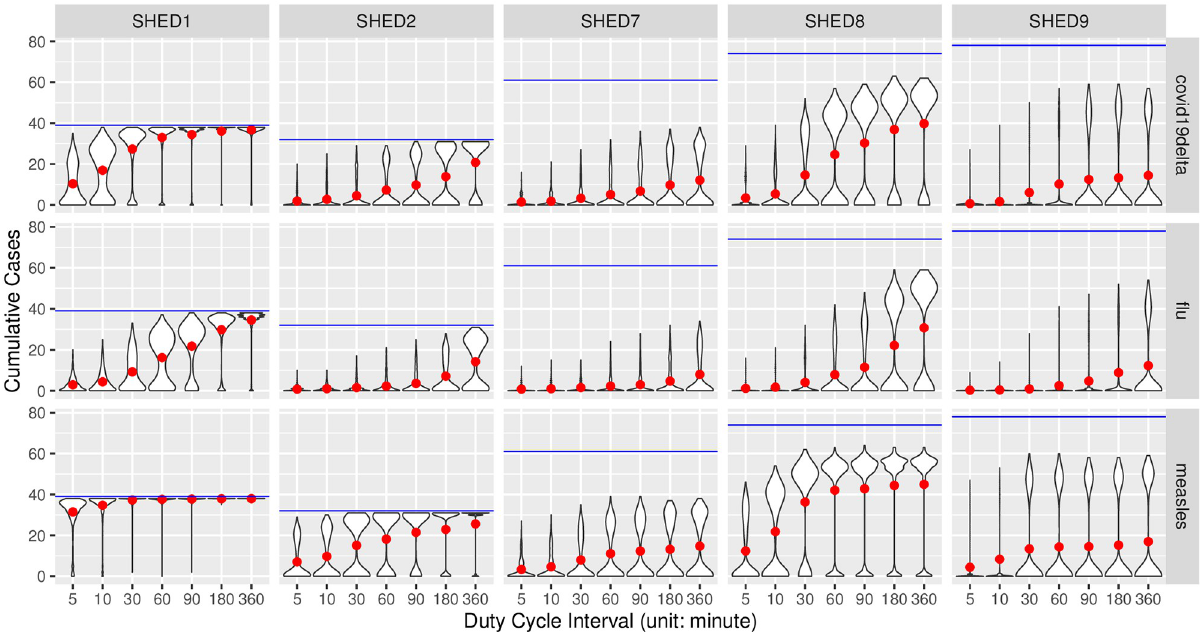
Fig 2. Grids of violin plots of cumulative cases for the Upperbound method. Figs 1 and 2 are two grids of violin-plots visualize the empirical distributions of the cumulative cases outcomes from the agent-based SEIR model informed by proximity contact data downsampled at different inter- observation intervals, given different diseases, within different underlying populations. At the highest level, we summarize simulated cumulative cases by downsampling methods, resulting in two subfigures having a similar arrangement, referred to here as a violin-plot grid. One such grid is present for each of the Snapshot and the Upperbound downsampling methods. Each such grid characterizes how cumulative cases vary by disease (row), and dataset (column). Within each cell of the violin-plot grid, violin-plots of cumulative cases are arranged from left to right according to the increasing inter-observation interval, with a 5-minute interval being the left-most, and 360-minute being the right-most. Each violin-plot shows the distribution of simulated cumulative cases over different random seeds and initially infected individuals at the inter-observation interval denoted by its horizontal axis label. The size of underlying population is denoted with blue lines, and the red dots indicate mean values of corresponding violin plot-denoted cumulative cases